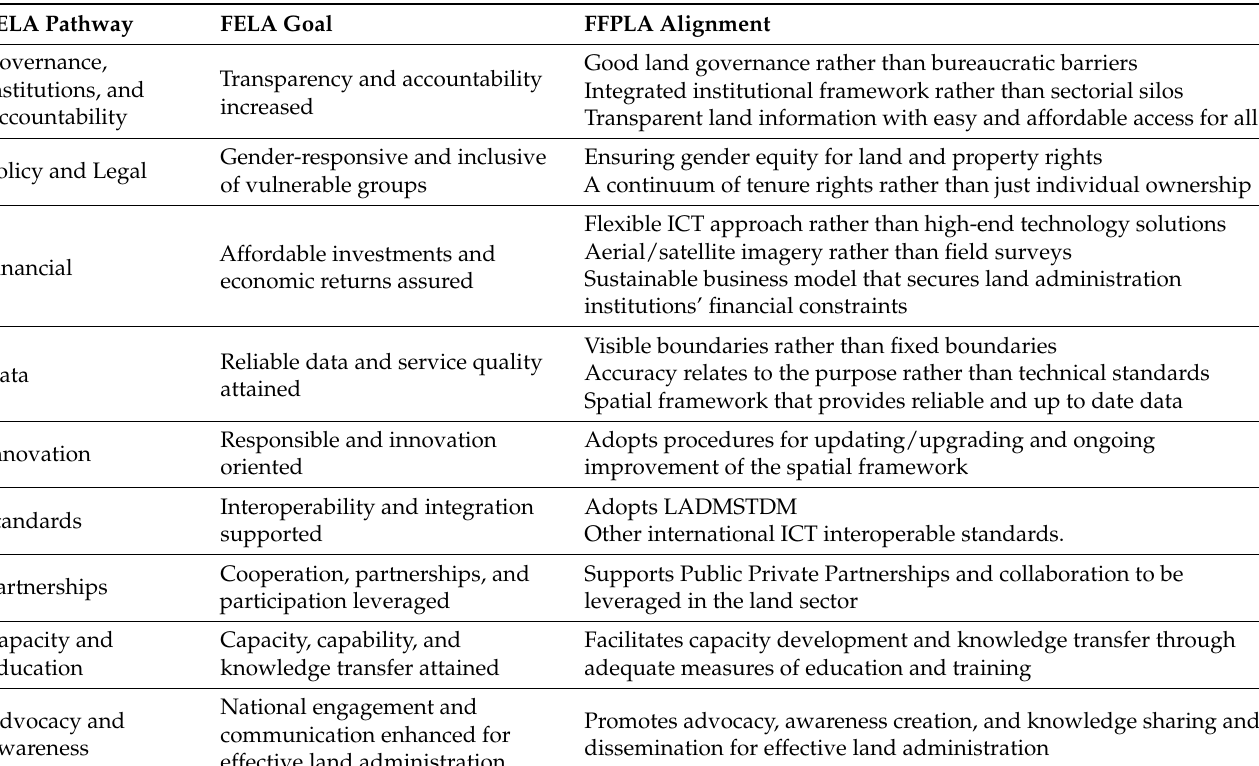
Table 3. FFPLA alignment with the FELA pathway goals adapted from [9,14]. FFPLA